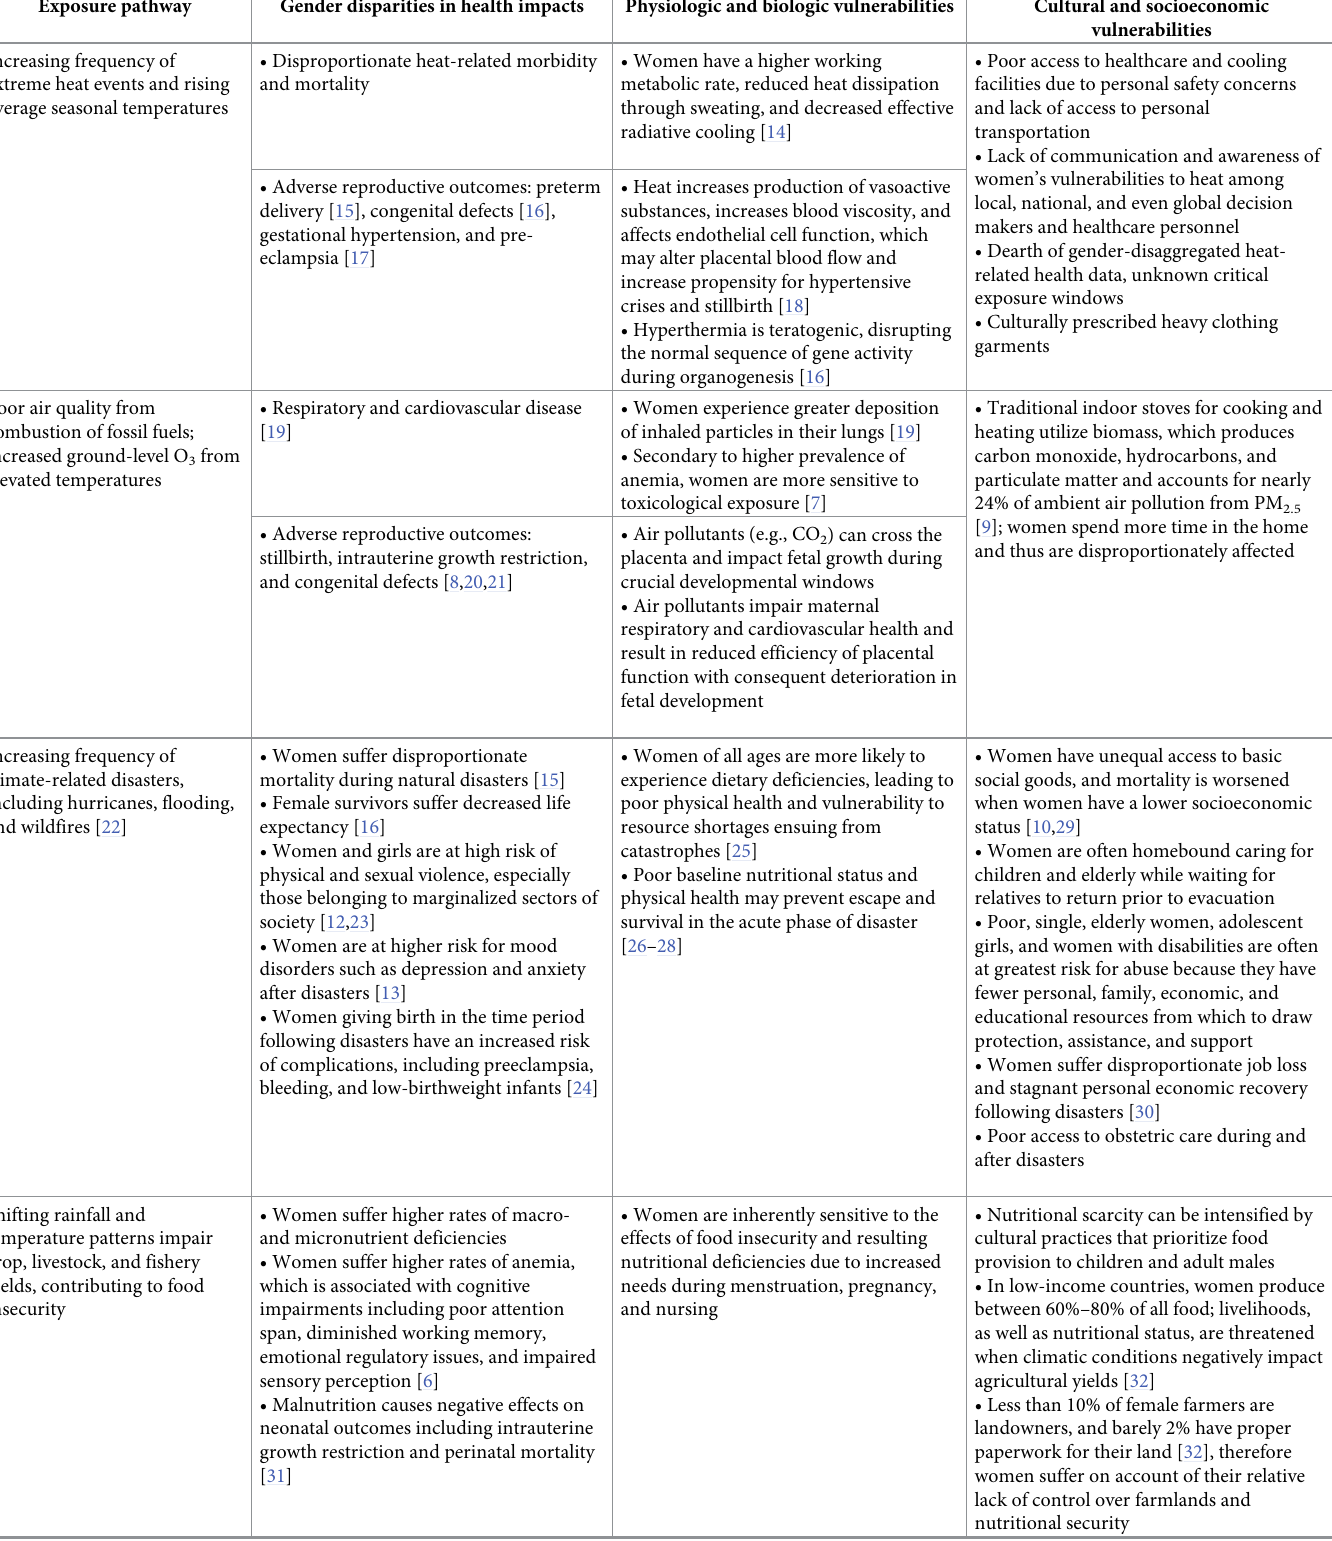
Table 1. Examples of disparate climate-related health impacts on women and relevant physiologic, cultural, and socioeconomic risk factors. Exposure